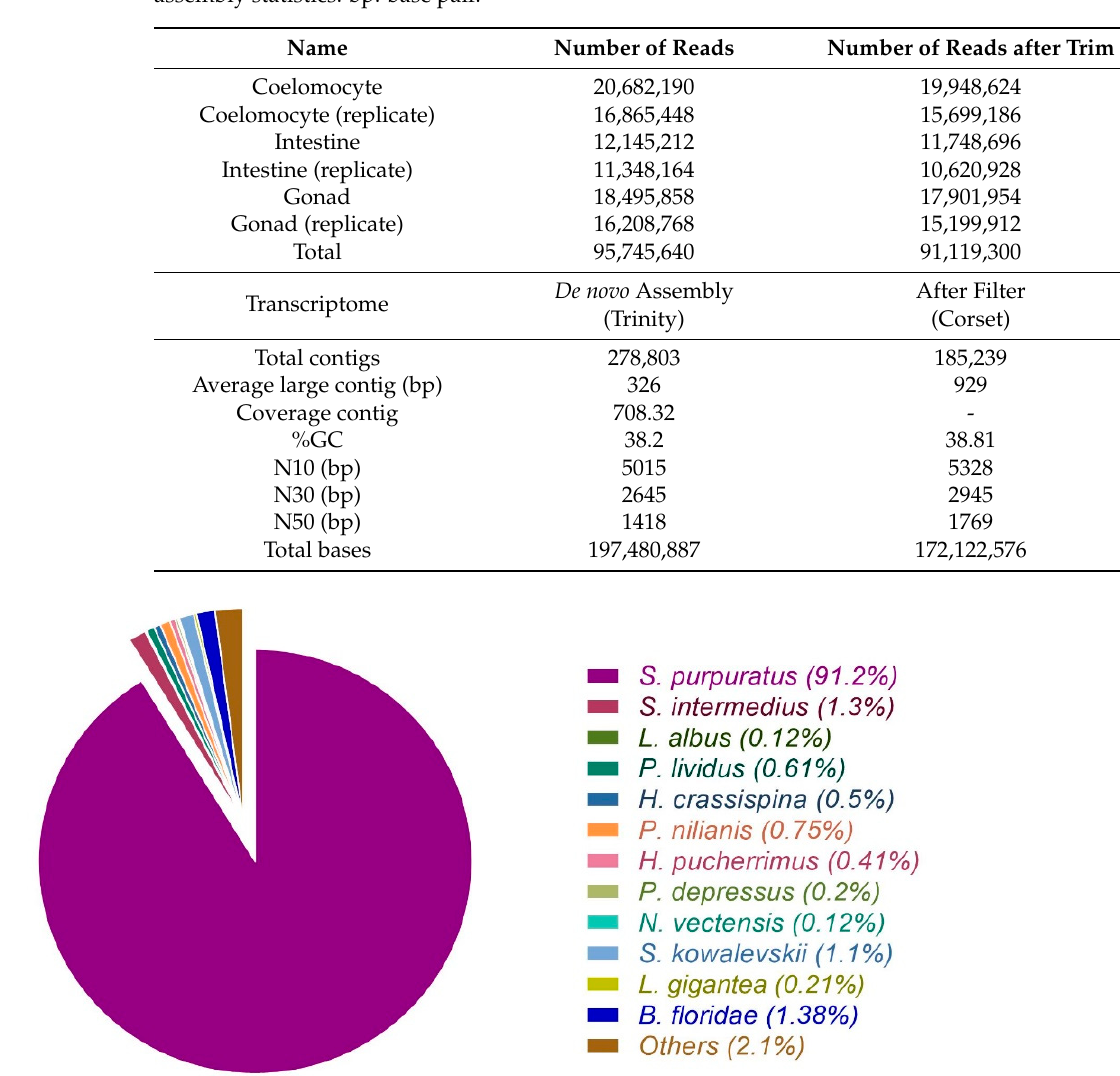
Table 1. Summary of transcriptome sequencing for the edible red sea urchin ( L. albus ) tissue and assembly statistics. bp: base pair.